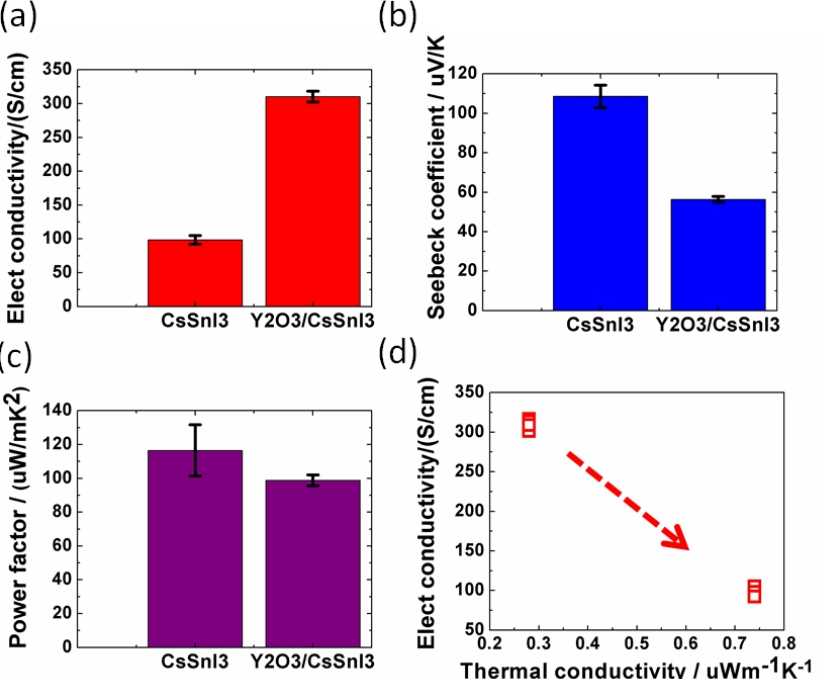
Figure 27. ( a ) Electrical conductivity variation CsSnI 3 vs. CsSnI 3 /Y 2 O 3 , ( b ) Seebeck coefficient variation CsSnI 3 vs. CsSnI 3 /Y 2 O 3 , ( c ) Power factor variation CsSnI 3 vs. CsSnI 3 /Y 2 O 3 ( d ) Thermal conductivity variation CsSnI 3 vs. CsSnI 3 /Y 2 O 3 . Reproduced with permission [76]. Copyright 2020, Elsevier.